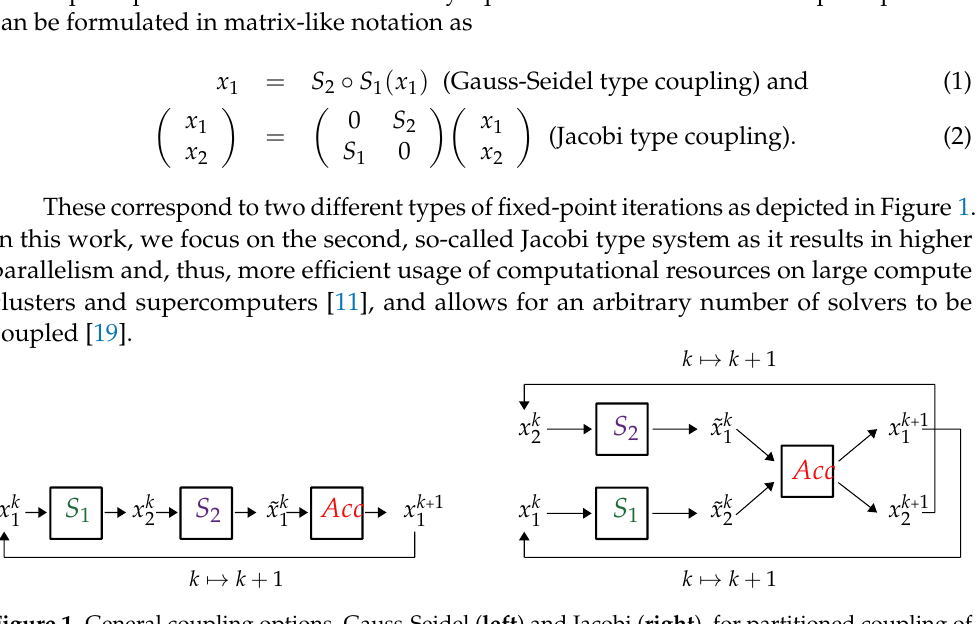
Figure 1. General coupling options, Gauss-Seidel ( left ) and Jacobi ( right ), for partitioned coupling of two solvers S 1 and S 2